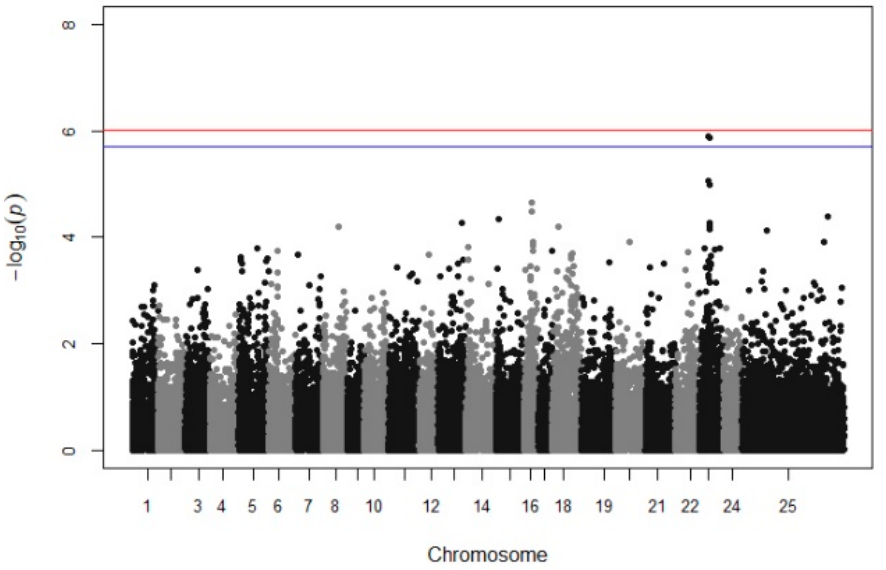
Figure 2. Manhattan plots for the multivariate GWAS of body weight. The red (initial value 0.05) and the blue line (initial value 0.1) illustrate the threshold after Bonferroni correction (at the genomic level). Focusing on univariate GWAS for batch 10, two SNPs were associated with the second, third, and fourth measurements of body weight on chromosome 16 (LG24) when only batch 10 was analyzed (Supplementary File S2, Figure S10). The proportion of phenotypic variance (PVE) for those SNPs ranged from 2.4% to 2.7% and from 2.5% to 2.9% (Table 6). Analyzing the batch 10 subgroup for disease resistance, 42.8% of the fish were dead until the 11th day of the experiment, and no significant association between SNP and disease resistance against Vibrio was found (Figure